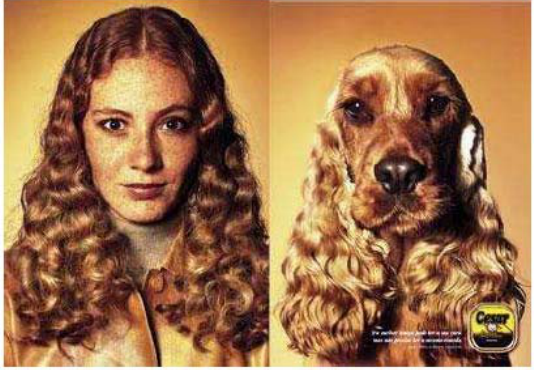
Fig. 1. Visual features of girl's image and the dog image are very similar, but both images belongs from different semantic class. (Image is taken from